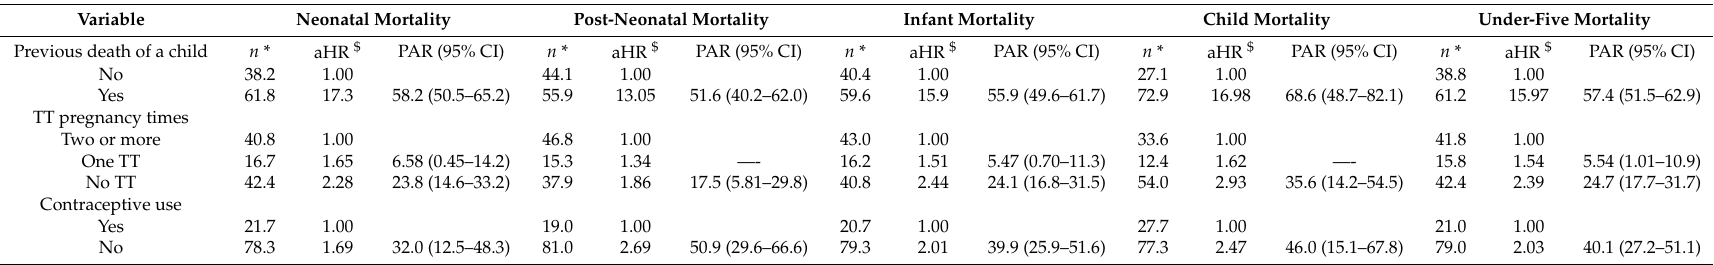
Table 3. Estimated PAR with 95% CI for common significant factors for child mortality across the five age groups in Nepal, 2001–2016 ( n = 15,750). Variable Neonatal Mortality Post-Neonatal